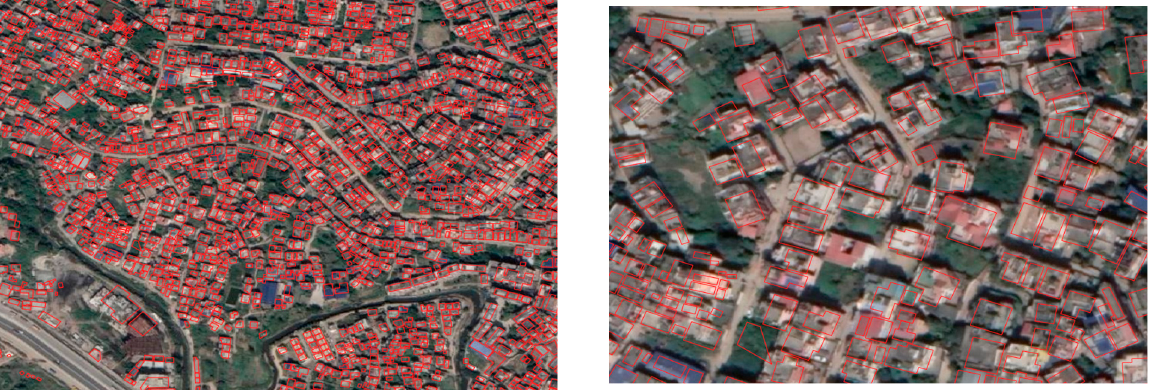
Figure 4. Building polygons overlaid on satellite imagery of Kathmandu (left) and Zoomed in view (right) from Google Earth TM .